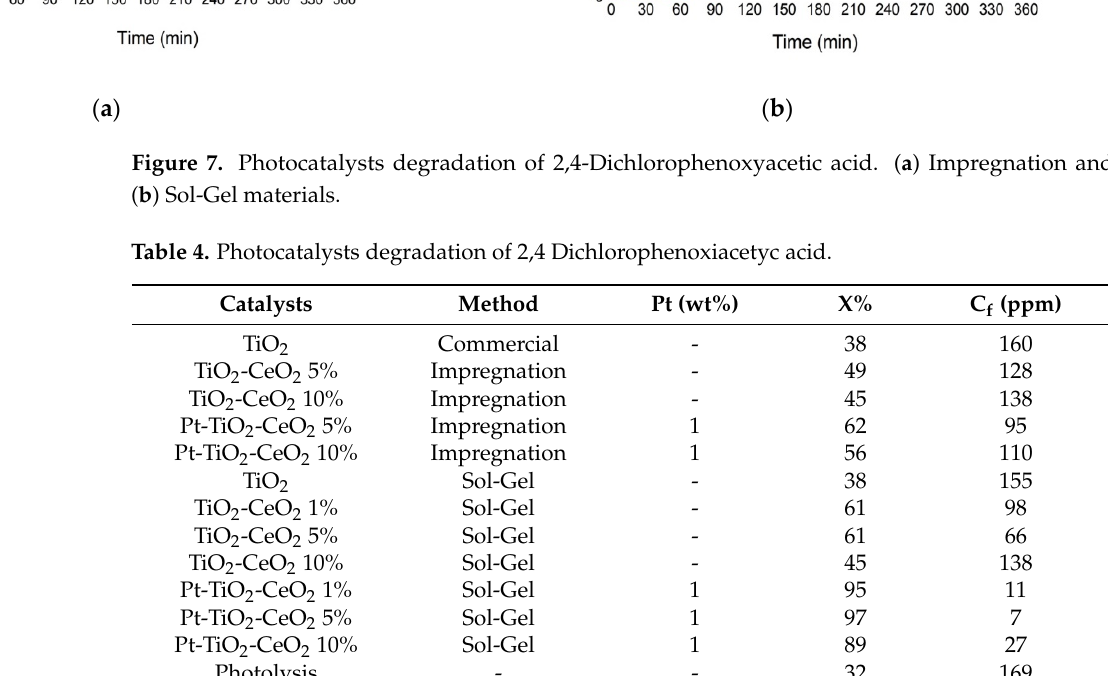
Table 4. Photocatalysts degradation of 2,4 Dichlorophenoxiacetyc acid.